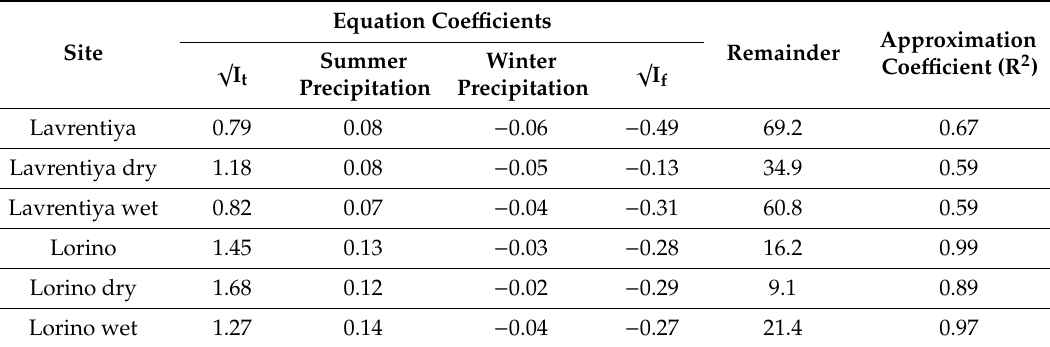
Table 5. Regression equations for CALM sites in Eastern Chukotka.